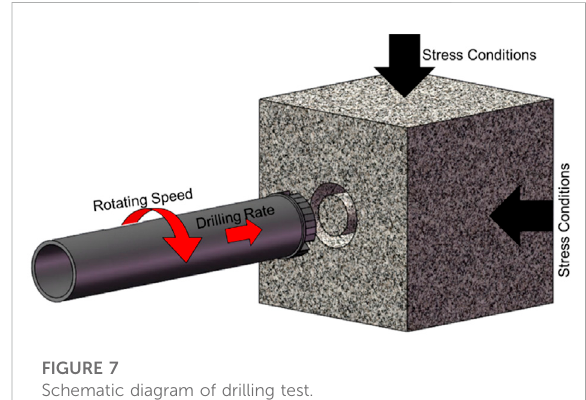
FIGURE 7 Schematic diagram of drilling test.